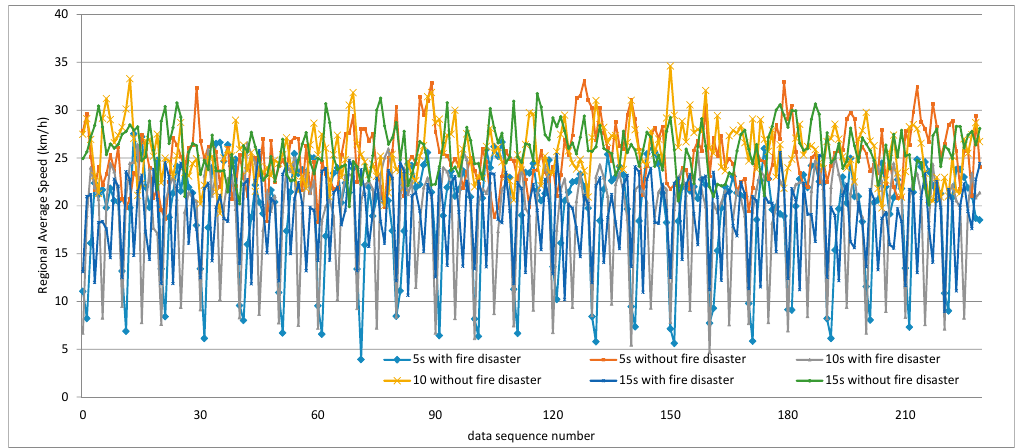
Figure 6. Dataset of regional average speed in different collecting time intervals with and without sudden fire disasters.